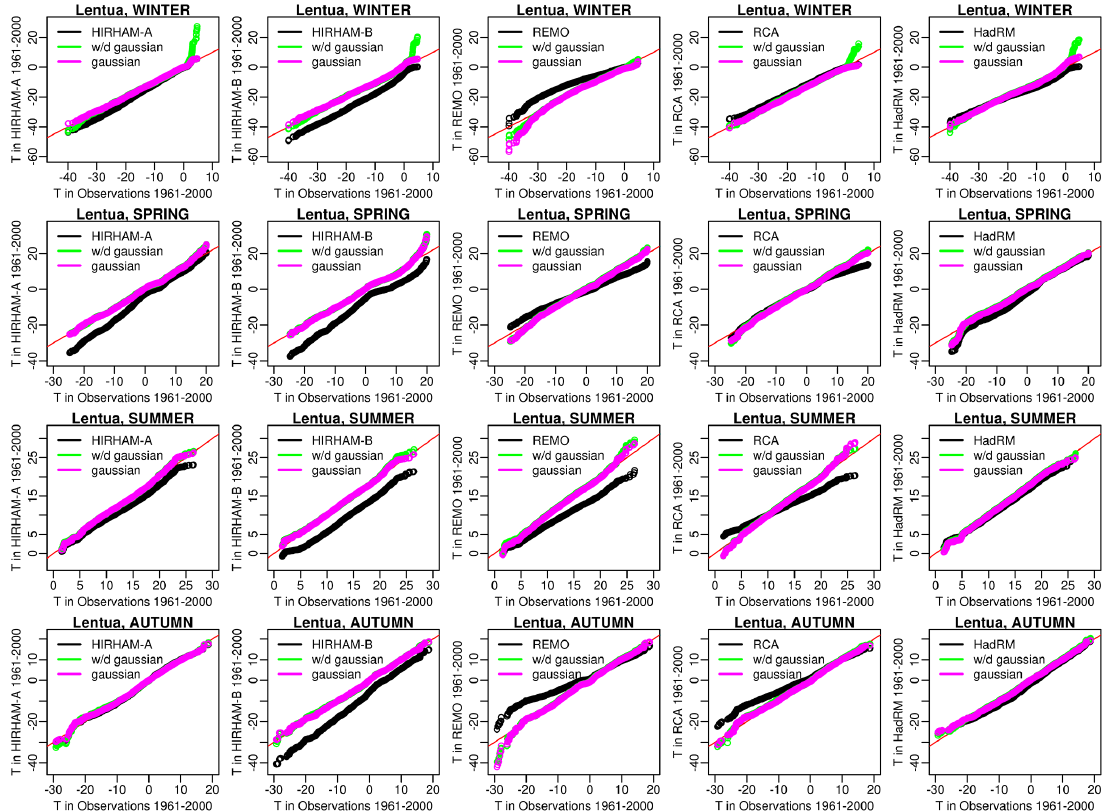
Figure 7. Comparison between uncorrected (black) and DBS-adjusted (pink without wet–dry state separation and green with wet–dry state separation) daily temperatures during control period 1961–2000 in Lentua. Red line corresponds to the